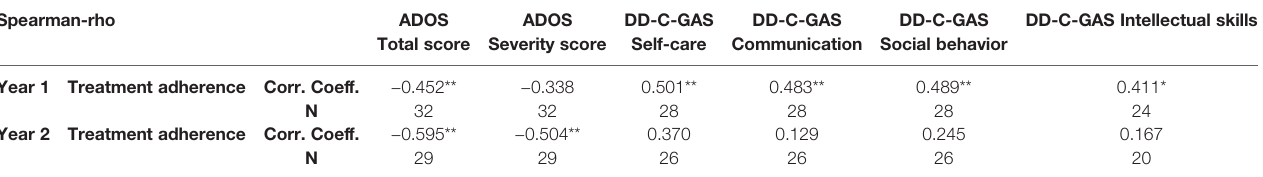
ADOS DD-C-GAS DD-C-GAS DD-C-GAS DD-C-GAS Intellectual skills Total score Severity score Self-care Communication Social behavior